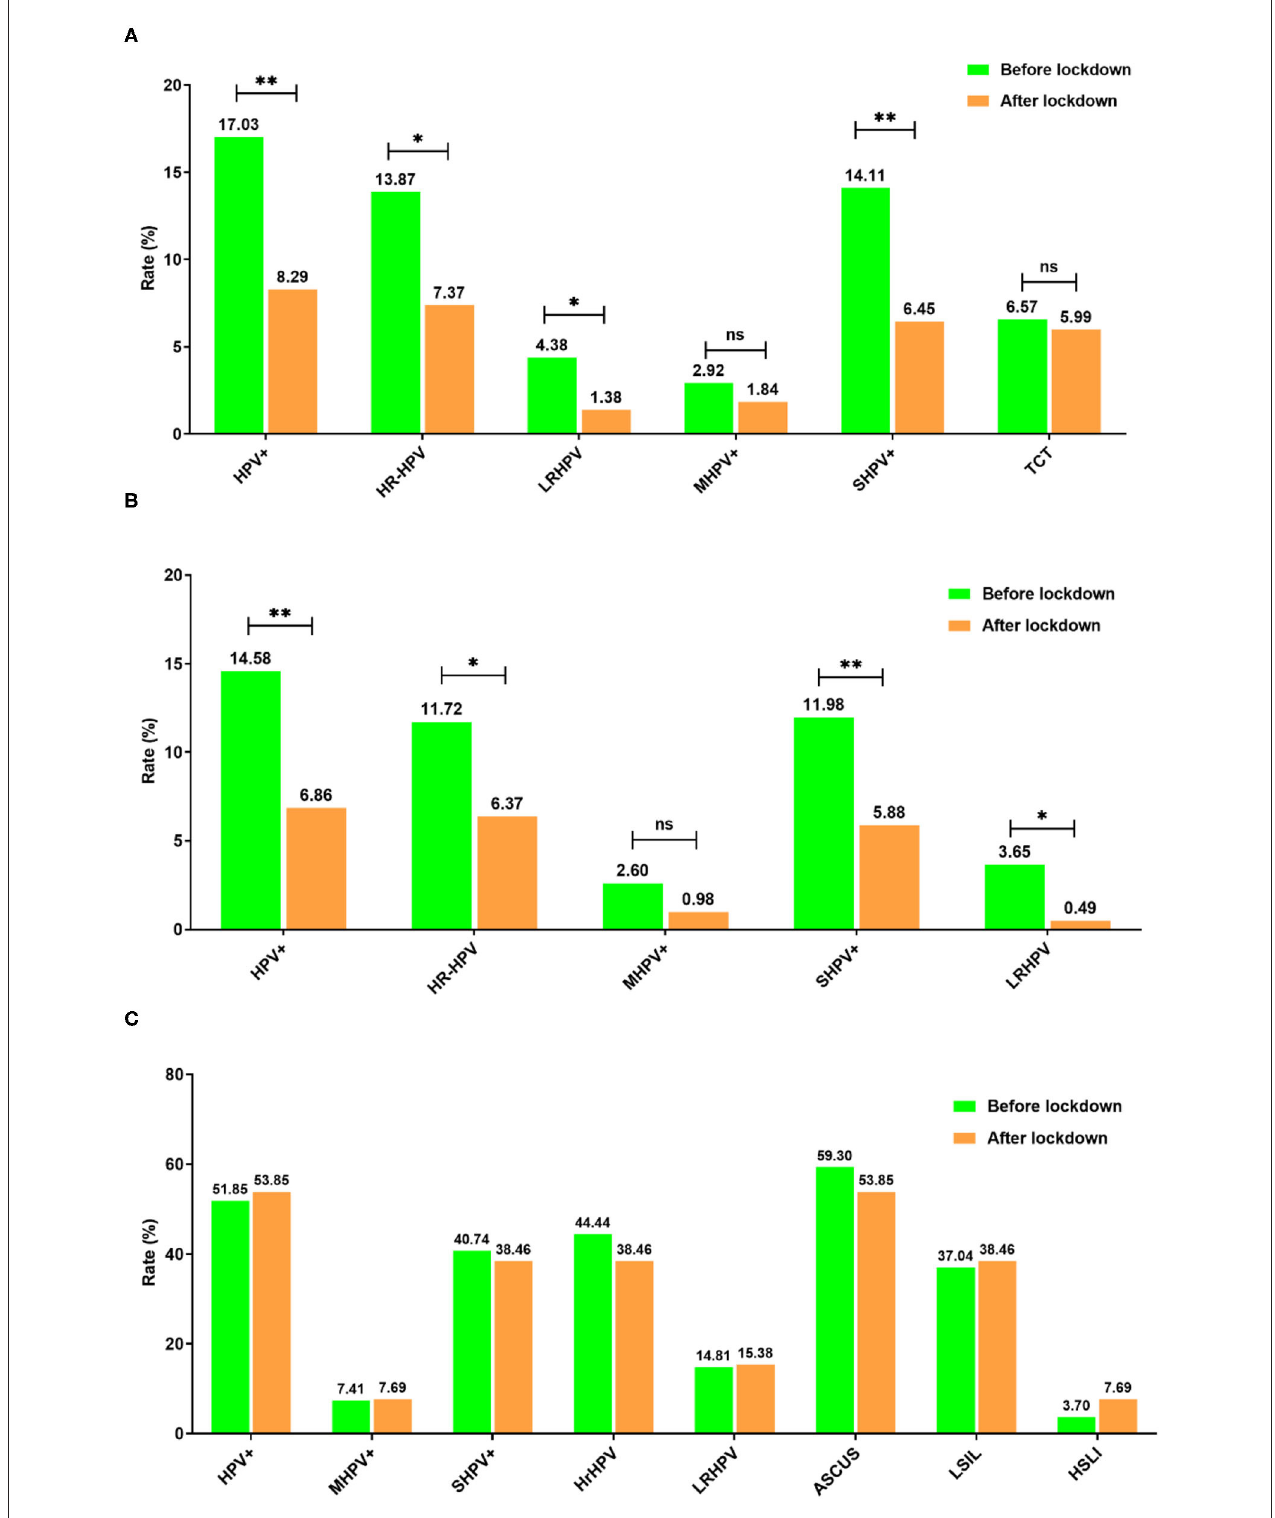
FIGURE 4 | Comparison of month HPV infection rates before and after the lockdown period. (A) Overall population; (B) TCT normal population; (C) TCT abnormal population. * P < 0.05 and ** P < 0.01.